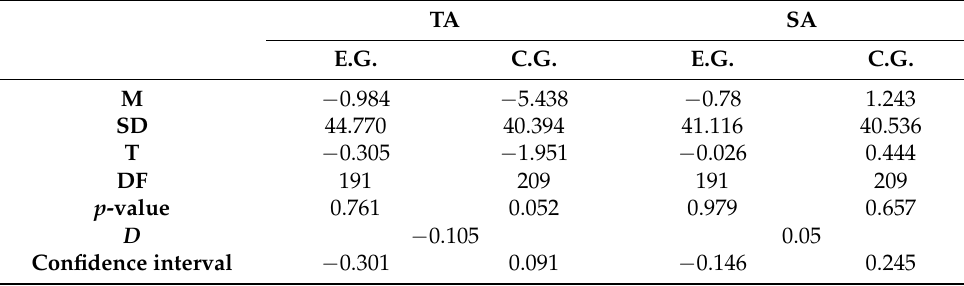
Table 6. Inferential analysis of anxiety in the EG and the CG in the pretest-posttest.